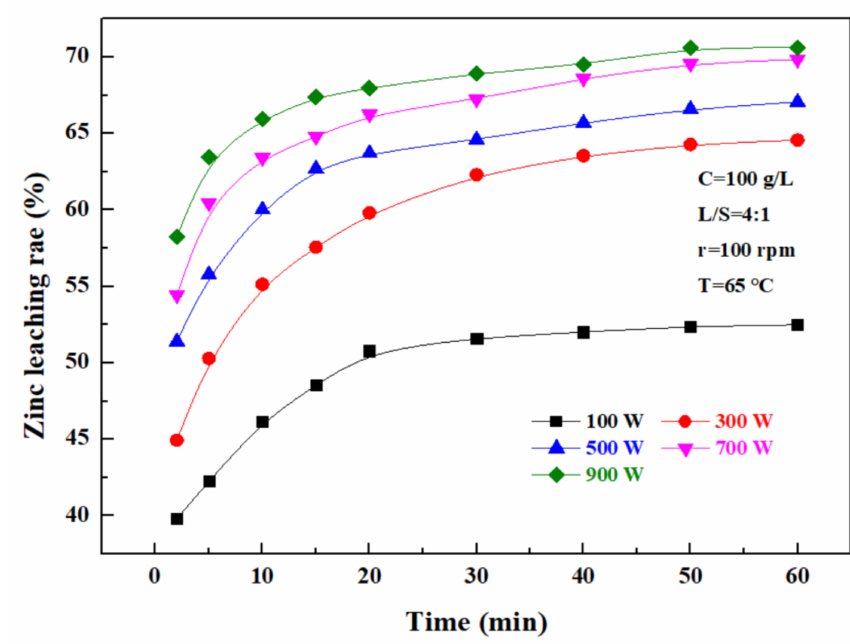
Figure 6. Effect of ultrasonic power on zinc leaching